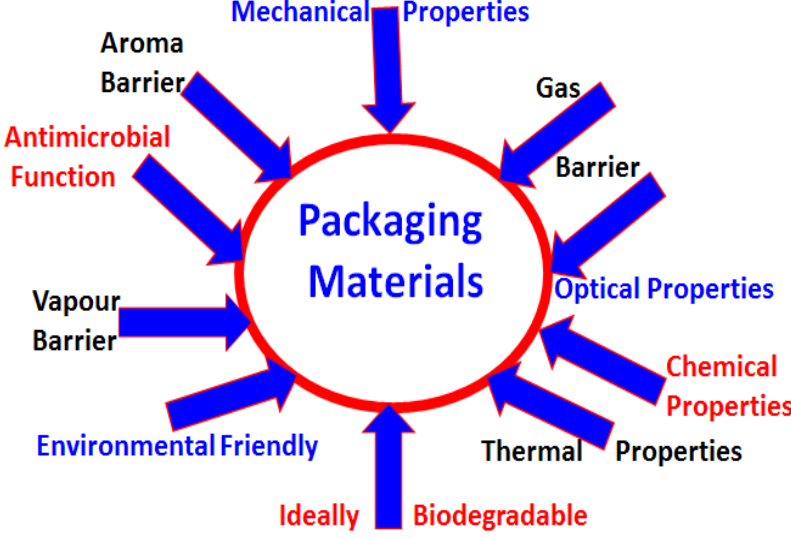
Figure 1. General properties of commonly used packaging materials.